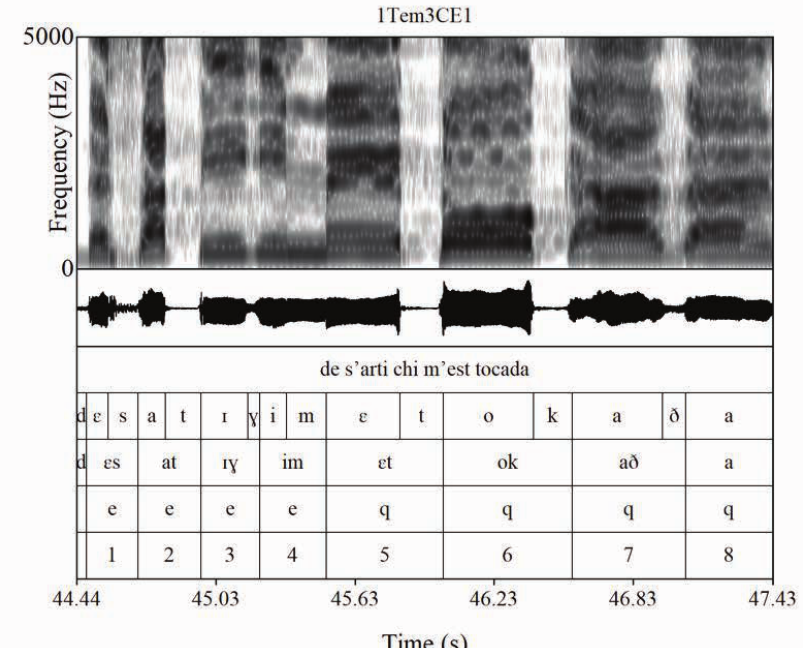
Figure 5: An example of an annotated halfline. From top to bottom: [1] orthographic transcription; [2] broad phonetic transcrip- tion; [3] V-to-V intervals; [4] musical transcription (durations); [5] metrical positions. In the panel above is the broad-band spectrogram with the waveform of the corresponding audio